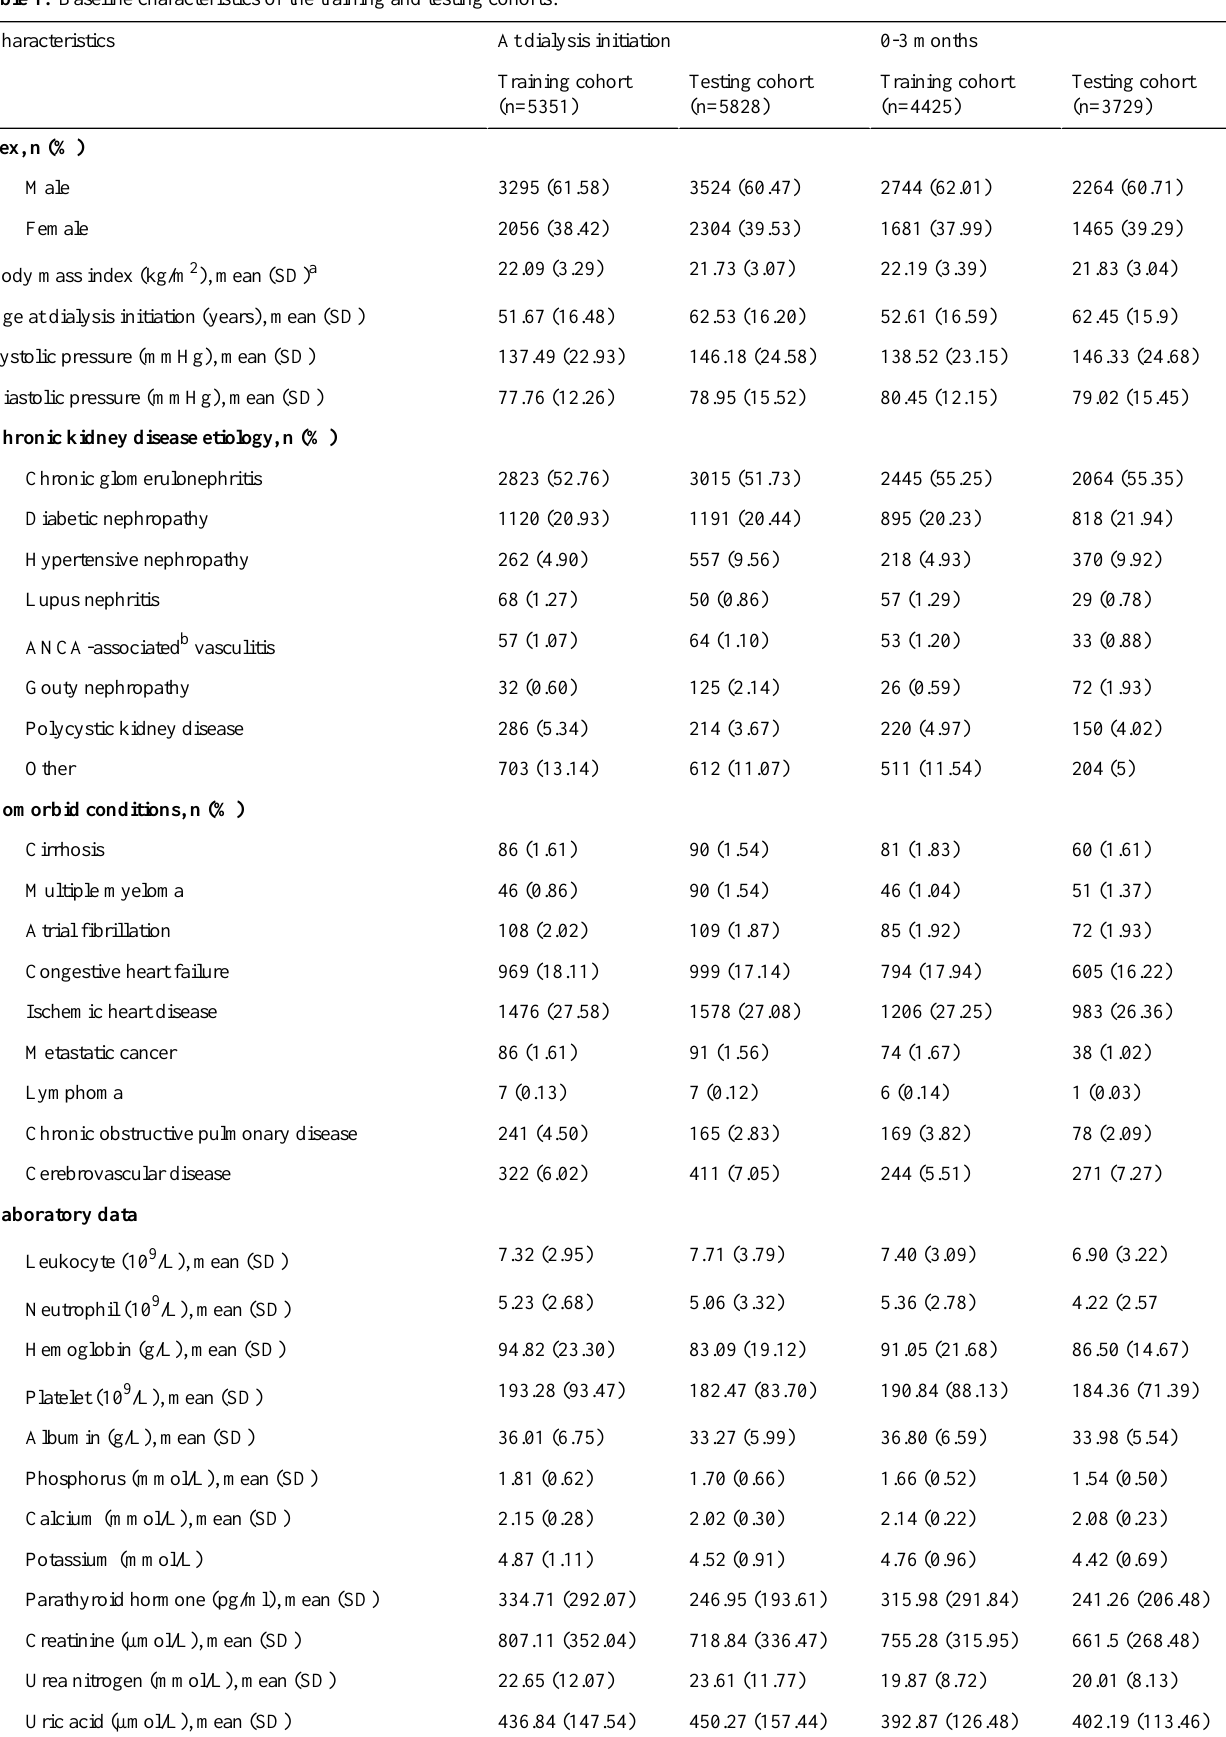
Table 1. Baseline characteristics of the training and testing cohorts.